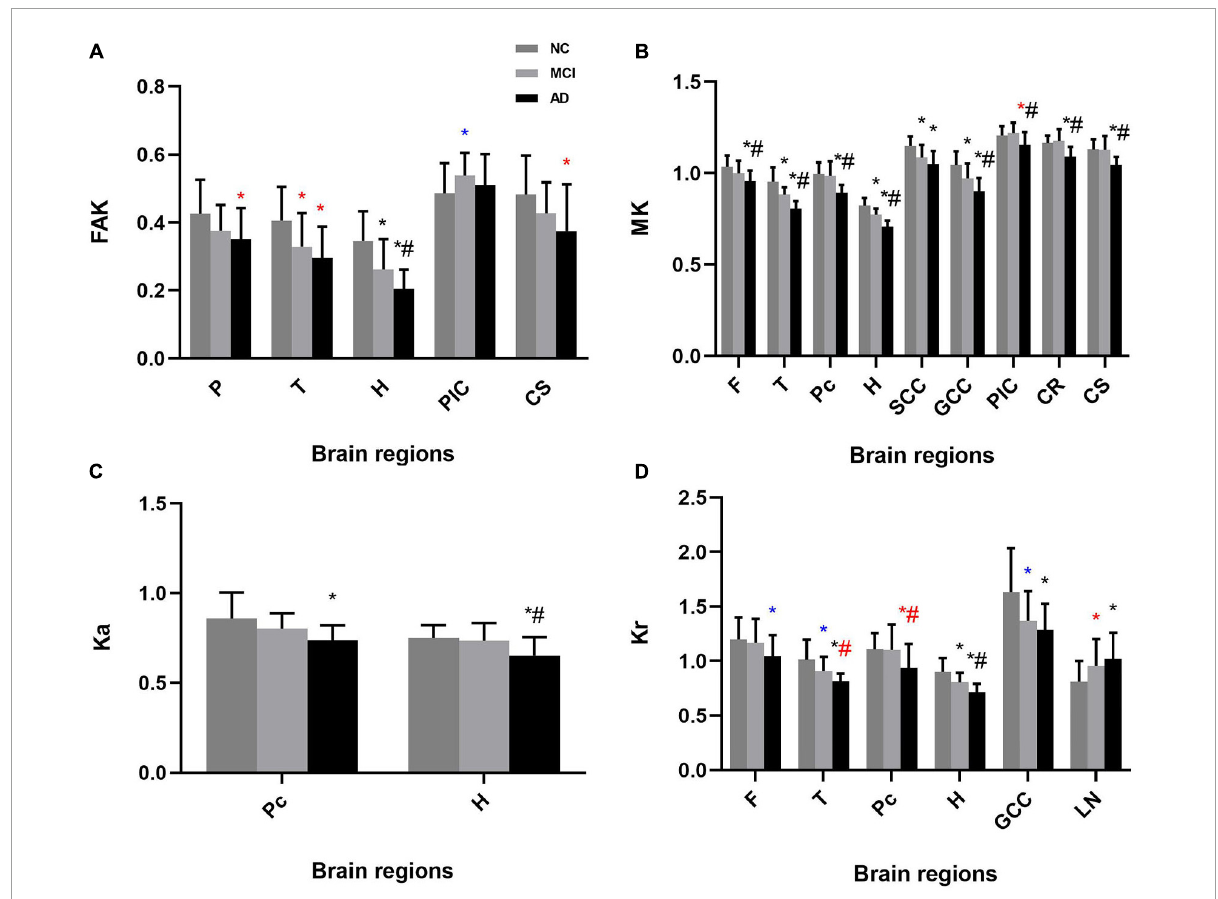
FIGURE4 Mean ( ± standard deviation) kurtosis for each ROI for each study group in both one-way analysis of variance (ANOVA) and analysis of covariance (ANCOVA). (A) FAK, (B) MK, (C) Ka, and (D) Kr showed significant differences between groups. AD patients had lower kurtosis in most ROIs than the MCI and normal cognition groups. NC, normal cognition; MCI, mild cognitive impairment; AD, Alzheimer’s disease; FAK, fractional anisotropy of kurtosis; MK, mean kurtosis; Ka, axial kurtosis; Kr, radial kurtosis; F, frontal lobe; P, parietal lobe; O, occipital lobe; T, temporal lobe; Pc, precuneus; H, hippocampus; SCC, splenium of the corpus callosum; GCC, genu of the corpus callosum; PIC, posterior limb of the internal capsule; LN, lenticular nucleus; CR, coronal radiata; CS, centrum semiovale. ∗ p < 0.05 vs. NC group in ANOVA, # p < 0.05 vs. MCI group in ANOVA; ∗ p < 0.05 vs. NC group in ANCOVA, # p < 0.05 vs. MCI group in ANCOVA; ∗ p < 0.05 vs. NC group in both analysis, # p < 0.05 vs. MCI group in both